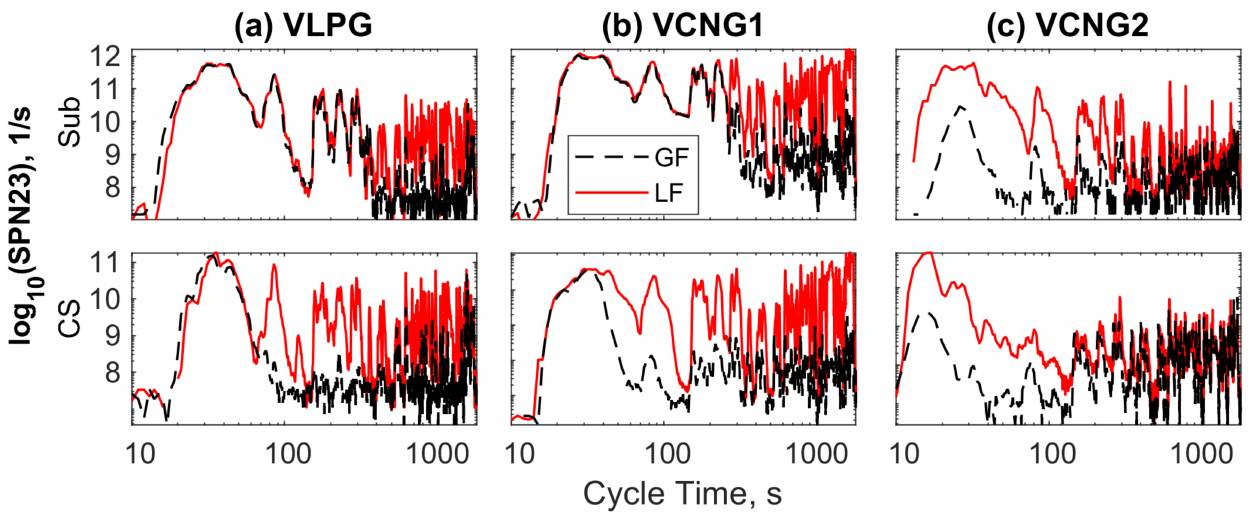
Figure 4. Sub-zero (Sub, top) and 23 ◦ C cold start (CS, bottom) SPN23 time series with liquid (LF) and gaseous (GF) fuel in sub-zero tests for ( a ) VLPG; ( b ) VCNG1; and ( c )